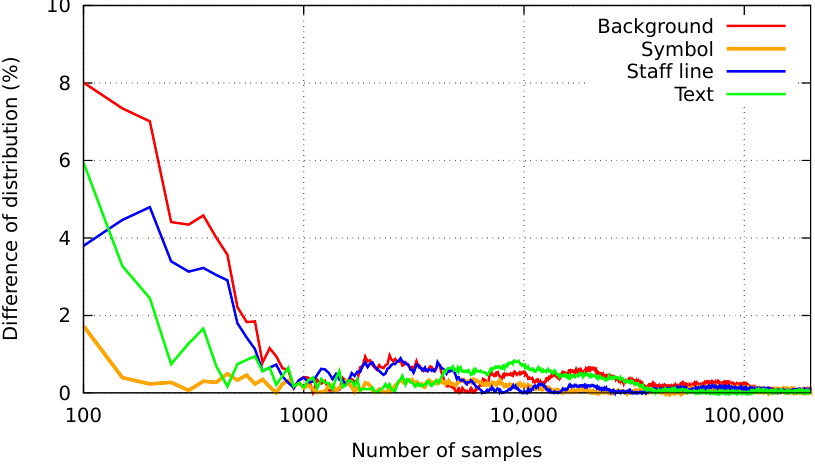
Figure 7. Difference of class distributions between real documents and random subset of pixels. The curves show that 100,000 random samples are enough to achieve a very similar distribution of classes to that of the original. Note that the x -axis presents a logarithmic